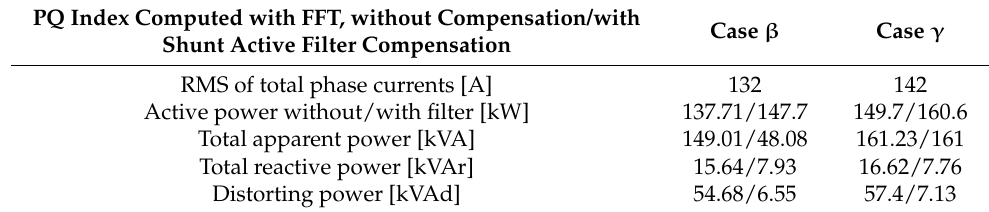
Table 7. Explanatory with the active filter efficiency evaluation from a technical point of view. PQ Index Computed with FFT, without